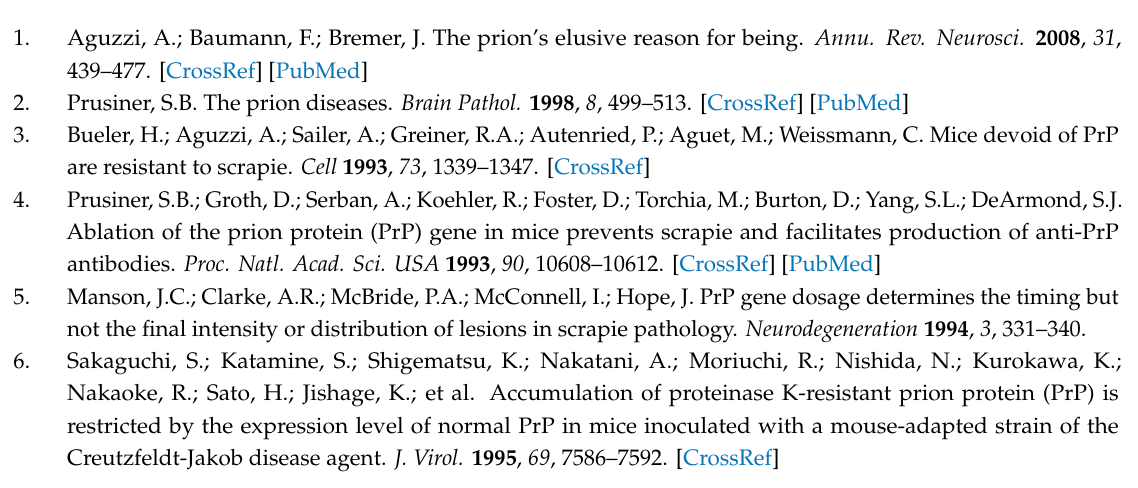
Figure 3A–D, Figure S4: (A) HE staining and immunohistochemistry for WT PrP Sc and PrP Sc ∆ 91–106 with SAF83 anti-PrP antibody of the brains of RML-infected, terminally ill WT mice and Tg(PrP ∆ 91–106) / Prnp 0 / 0 mice sacrificed at 573 dpi with RML prions. (B) HE staining and immunohistochemistry for WT PrP Sc and PrP Sc ∆ 91–106 with SAF83 anti-PrP antibody of the brains of 22L-infected, terminally ill WT mice and Tg(PrP ∆ 91–106) / Prnp 0 / 0 mice sacrificed at 603 dpi with 22L prions. (C) HE staining and immunohistochemistry for WT PrP Sc and PrP Sc ∆ 91–106 with SAF83 anti-PrP antibody of the brains of FK-1-infected, terminally ill WT mice and Tg(PrP ∆ 91–106) / Prnp 0 / 0 mice sacrificed at 603 dpi with FK-1 prions, Figure S5: (A,B) Original, uncropped and unadjusted images of Figure 5A. (C,D) Original, uncropped and unadjusted images of Figure